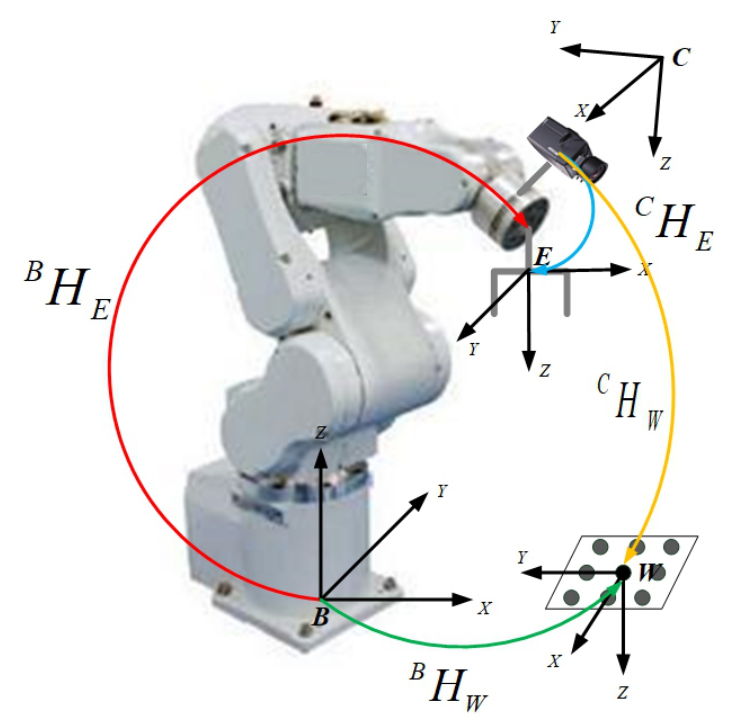
Figure 6. Hand eye